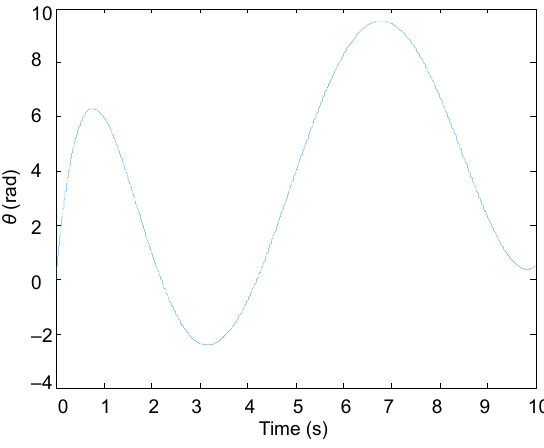
Figure 13. Angular displacement curve of the unit being tested.